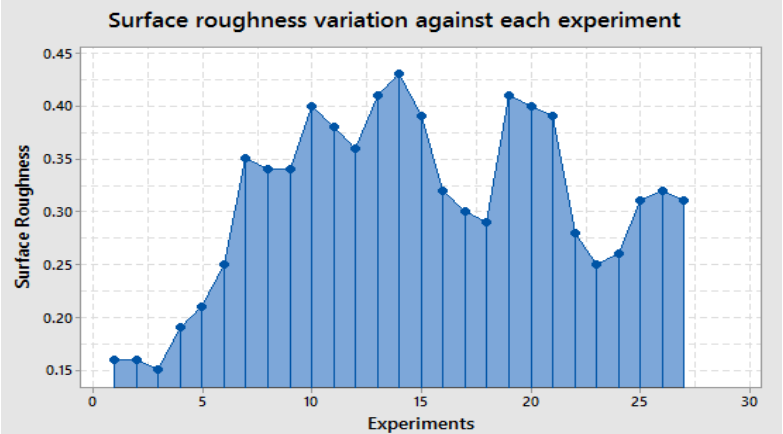
Figure 8. Scatterplot of surface roughness ( Ra ) against experiments.